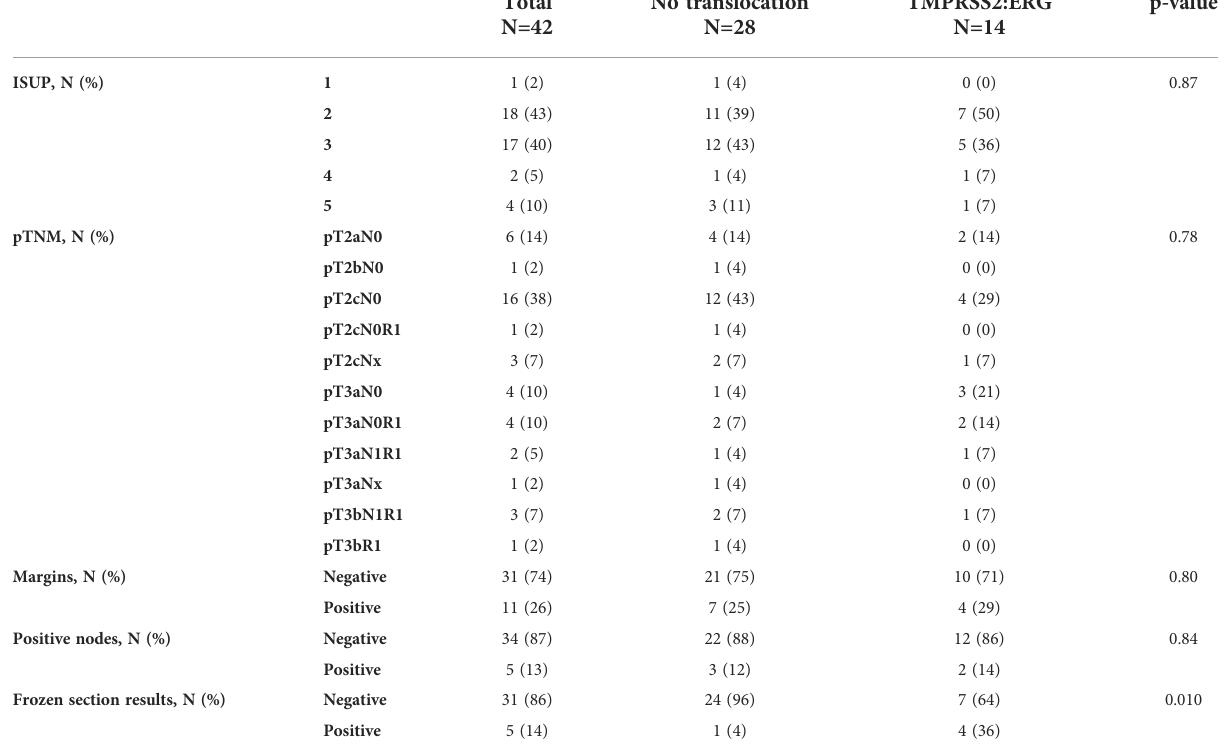
TABLE 4 Radical prostatectomy fi ndings by absence or presence of T2:ERG translocation.